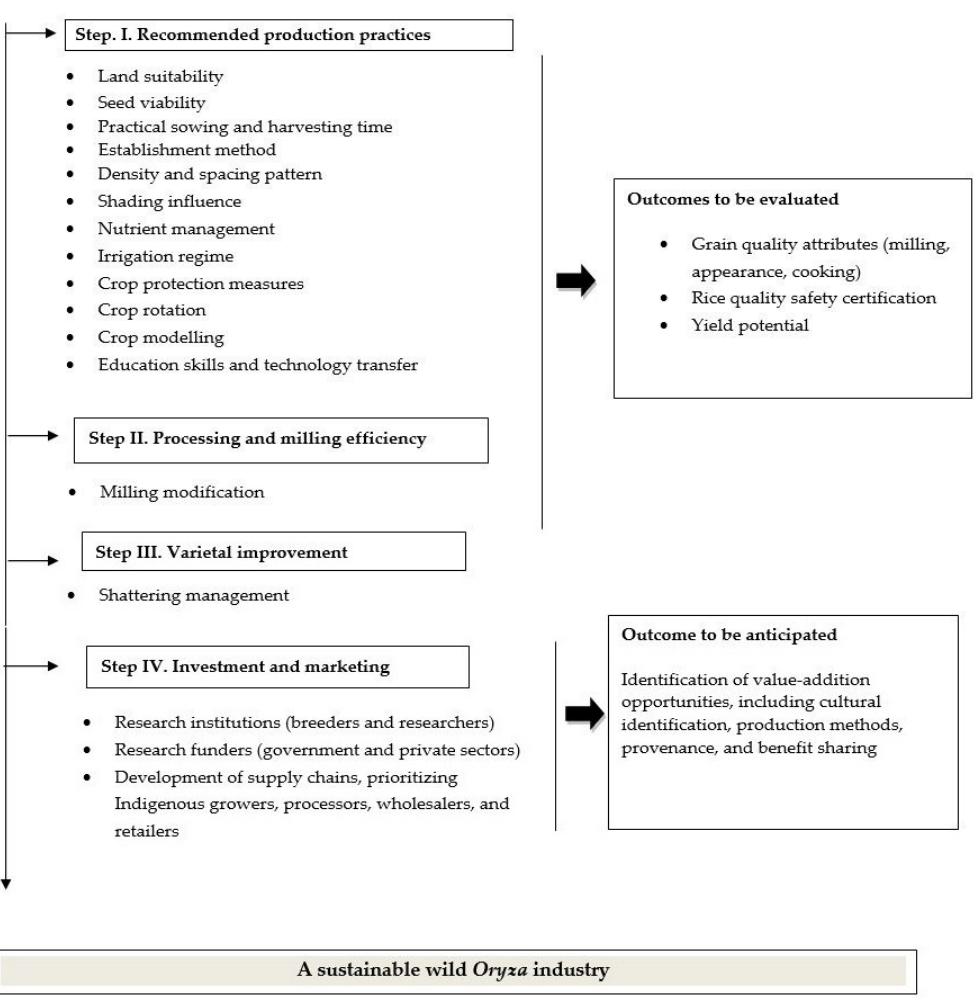
Figure 5. A conceptual framework for the development of a sustainable wild rice industry in northern Australia.